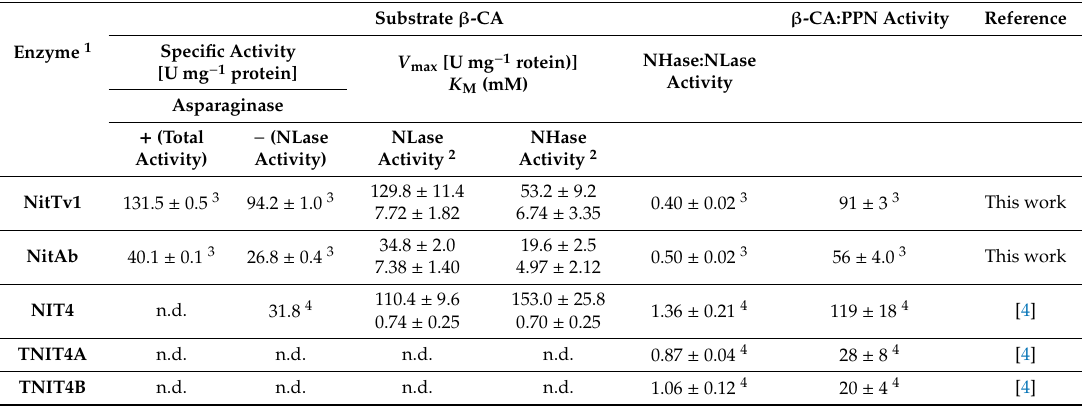
Table 2. Comparison of the catalytic properties of fungal nitrilases NitTv1 and NitAb and